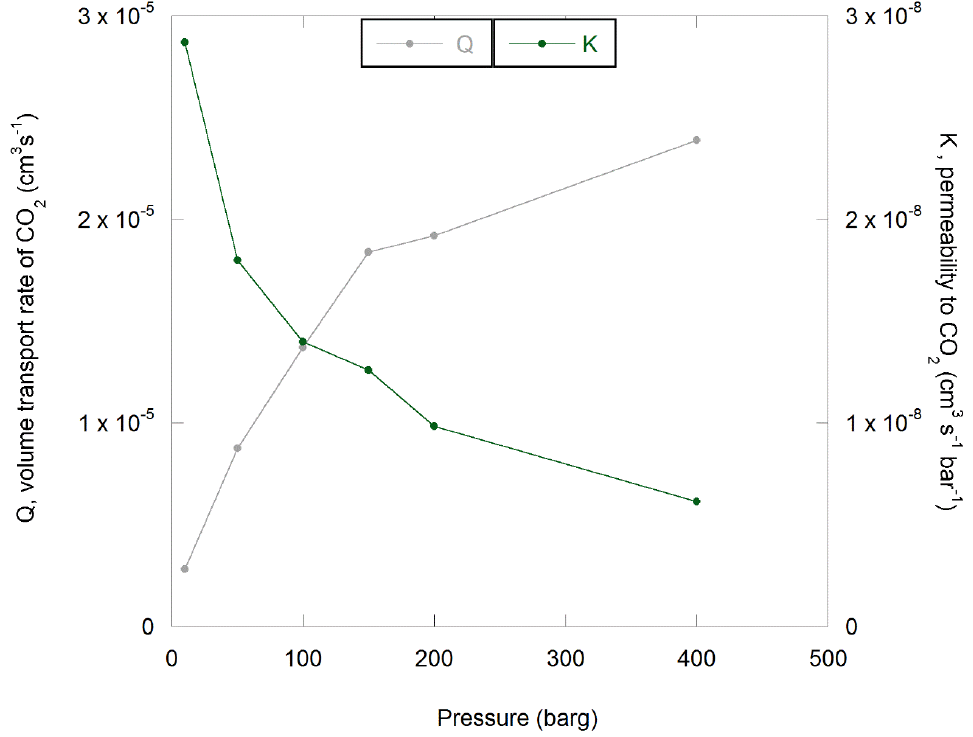
Figure 8. Volume flow rate ( Q ) and permeability ( K ) as a function of applied pressure for gaseous and supercritical CO 2 conditioned at 100 °C. Data from results presented in Figure 7.